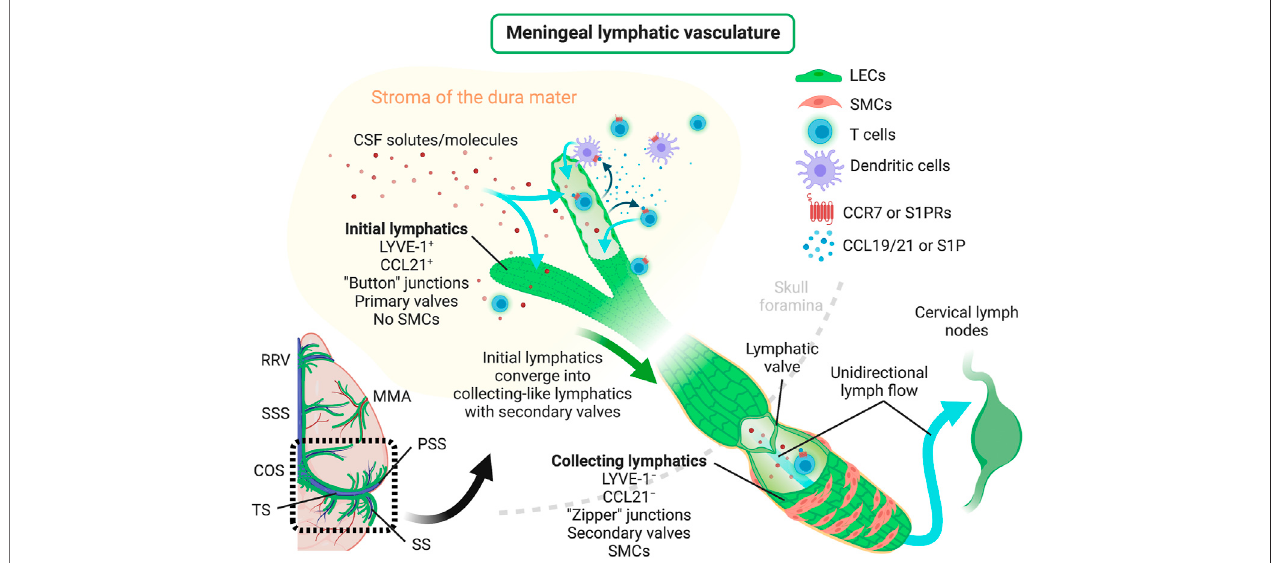
FIGURE1| Schemedepictingthestructureofmeningeallymphaticvessels,lymphaticdrainageofCSFsolutes/molecules,mechanismsregulatingthetraf fi ckingof immune cells through meningeal lymphatics and the unidirectional lymphatic fl ow into the brain draining CLNs. CCL19/21, C – C motif chemokine ligand 19/21; CCR7, C – C motif chemokine receptor 7; COS, con fl uence of sinuses; CSF, cerebrospinal fl uid; LECs, lymphatic endothelial cells; LYVE-1, lymphatic vessel endothelial hyaluronanreceptor-1;MMA,middlemeningealartery;PSS,petrosquamosalsinus;RRV,rostralrhinalvein;S1P,sphingosine-1-phosphate;S1PRs,sphingosine- 1-phosphate receptors; SMCs, smooth muscle cells; SS, sigmoid sinus; SSS, superior sagittal sinus; TS, transverse sinus. Created with BioRender.com.